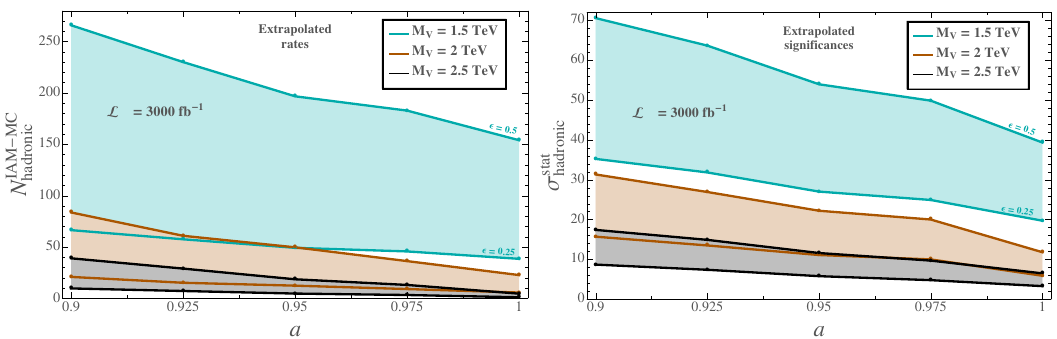
Figure 15 . Extrapolated JJjj signal event rates from (cid:12)gure 14 (for panel), and their corresponding extrapolated statistical signi(cid:12)cances (right panel), (cid:27) stat two lines shown for each resonance mass correspond, respectively, assuming an e(cid:14)ciency in the reconstruction of W ’s and Z ’s from the ‘fat jets’ of (cid:15) = 0 : 5 (upper line) and (cid:15) = 0 : 25 (lower